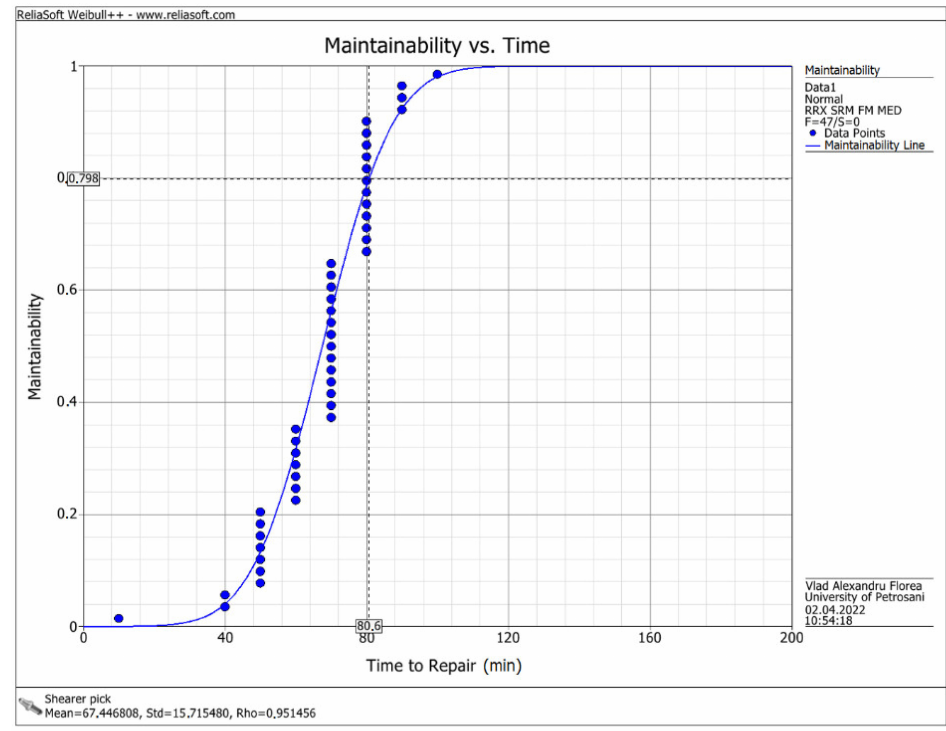
Figure 10. Cleat maintainability values for a 79,8% confidence level for the shearer picks.